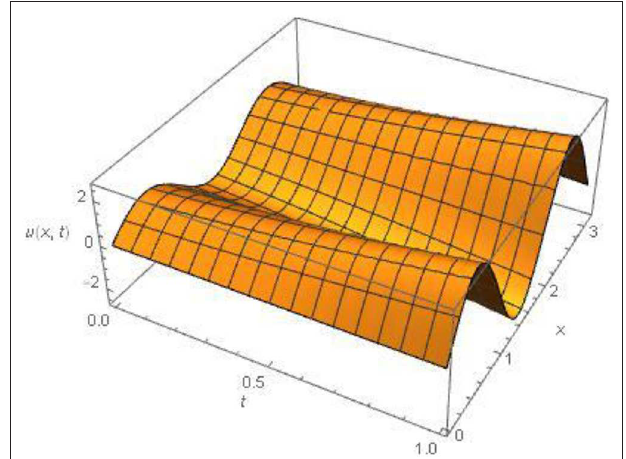
FIGURE 6 | Surface of Approximate solution for TFPPDE (29) with α